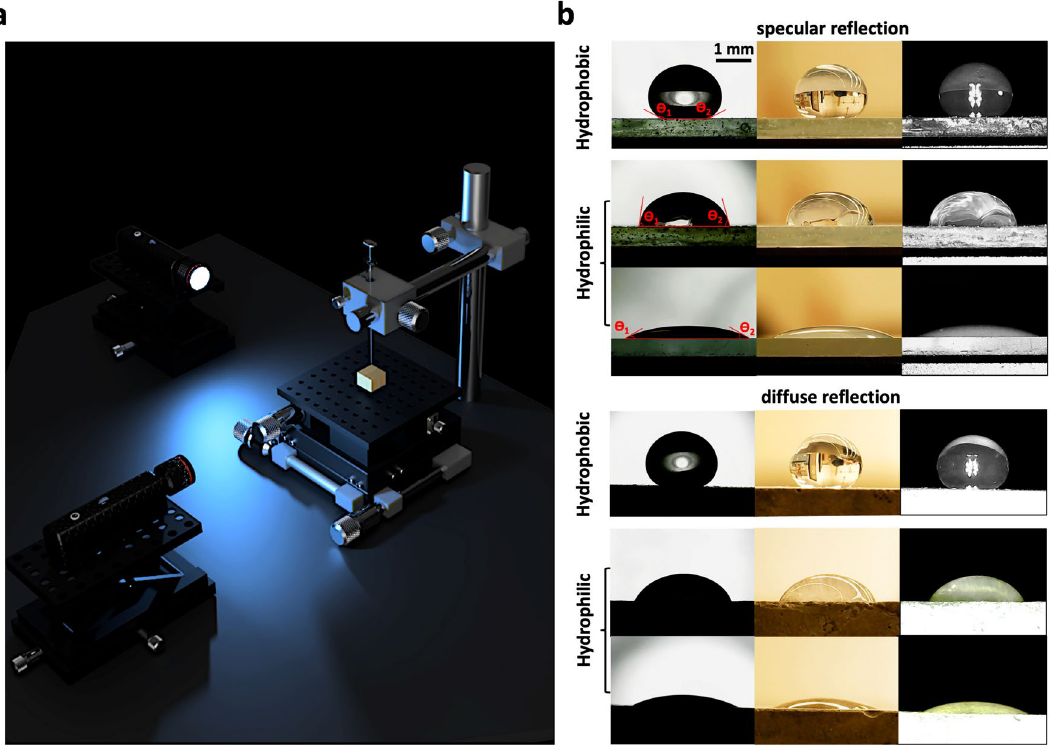
Figure 1. CA measurements via sessile drop method using an orthogonal camera setup. ( a ) A 3D schematic of the proposed setup that comprises two front-lit USB microscope cameras and a single XYZ mechanical stage placed in a dark room, ( b ) estimating CA on hydrophobic (top row) and hydrophilic (second and third rows) surfaces through back-lit (left column), normal lighting (middle column), and front-lit (right column) setups for drops sitting on substrates with specular (i.e., nonporous ceramic) or diffuse (i.e., porous ceramic)